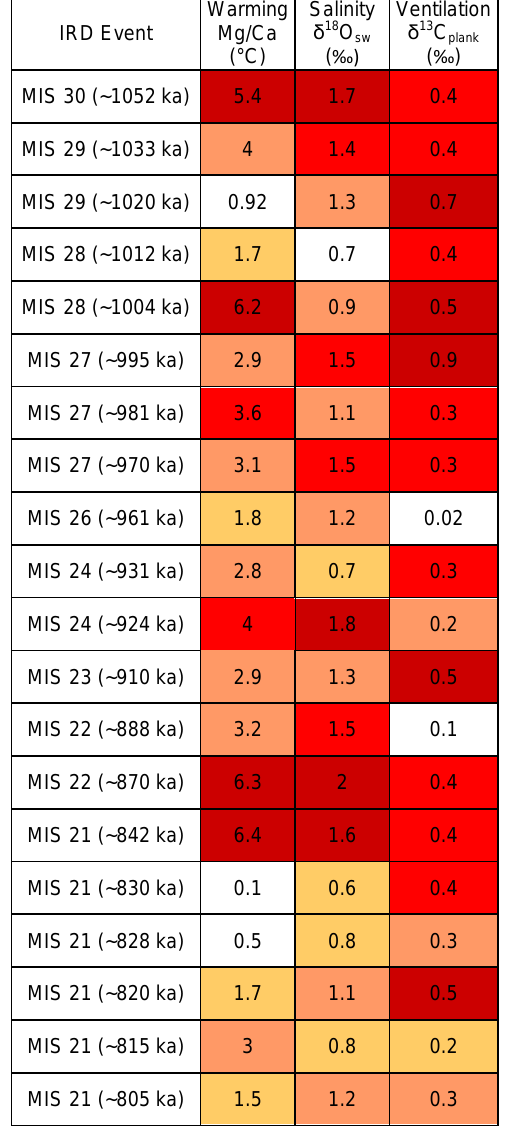
Table 1. Summary of the changes in Mg / Ca, δ 18 O sw and plank- tonic δ 13 C during the IRD events. The amplitude of the change is calculated from the difference between the point where δ 18 O sw starts to increase prior to the IRD event and the δ 18 O sw maxima during the IRD event. The events are colour-coded, deep red show- ing the strongest change, and white the